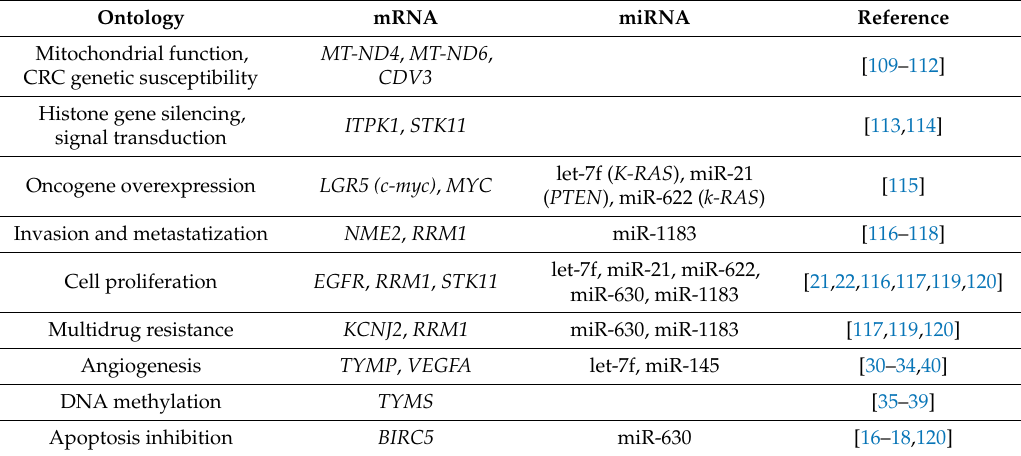
Table 3. Gene ontology and main regulatory roles of mRNA and miRNA associated with neoadjuvant rectal CRT response.